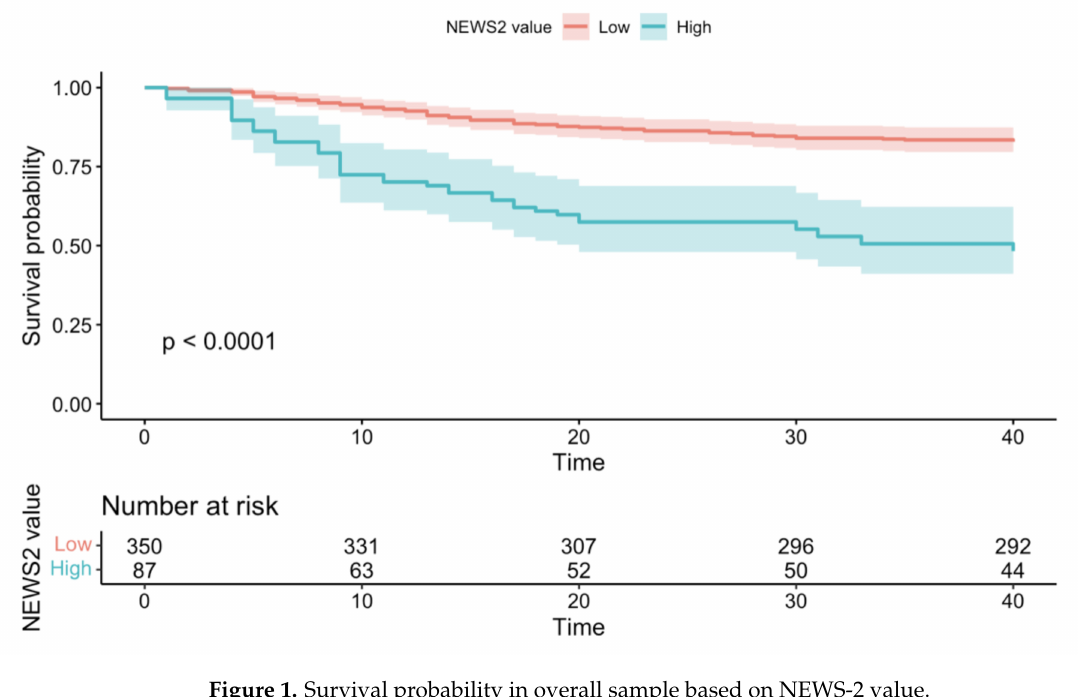
Figure 1. Survival probability in overall sample based on NEWS-2 value.